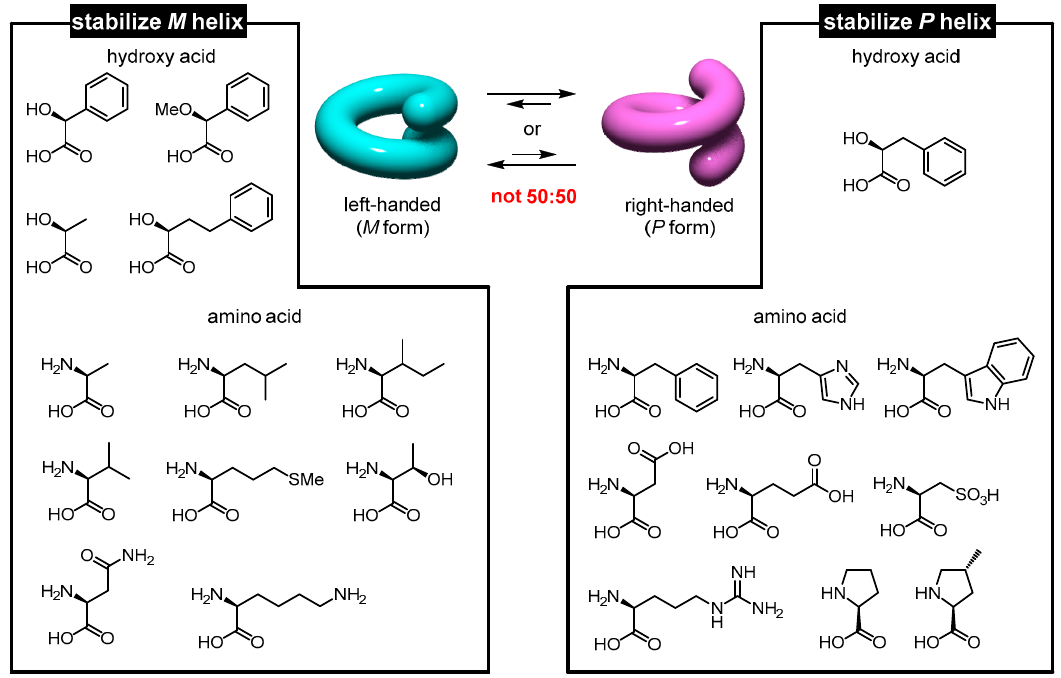
Figure 8. Helicity control of L 2 Zn 3 La by the coordination of hydroxy acid/DABCO (3 equivalent each) or amino acid (3 equivalent).